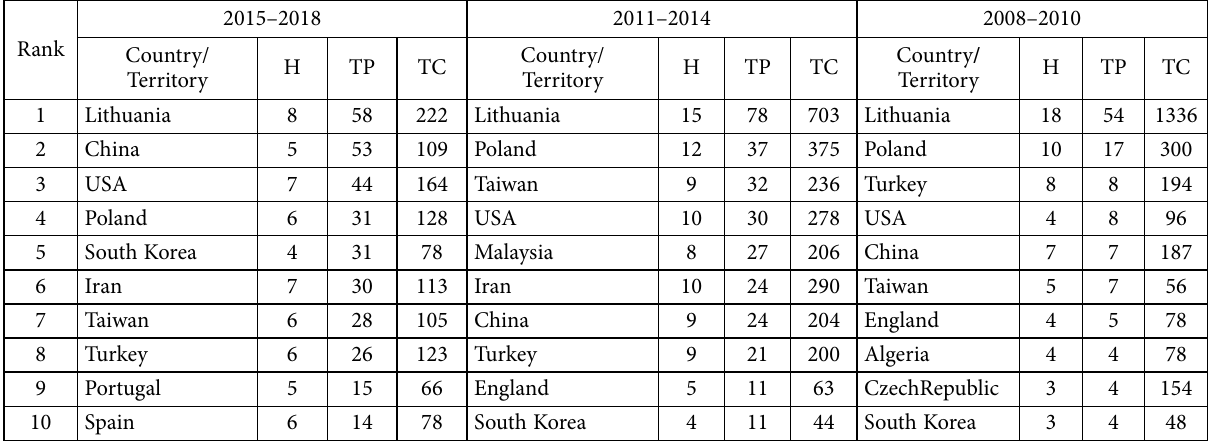
Table 3. Most productive influential countries/territories in three different stages